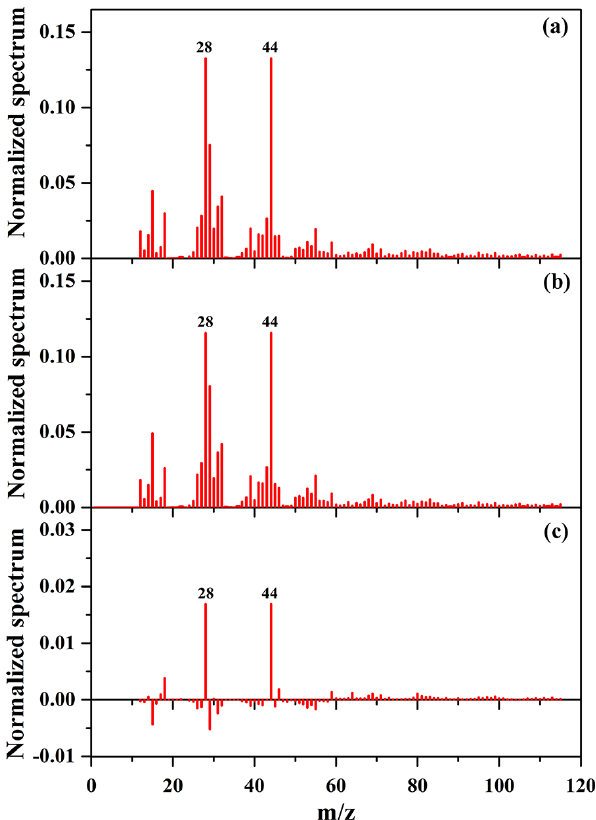
Figure 7. Mass spectra of SOA with NaCl (a) and ( NH 4 ) 2 SO 4 (b) as seed particles obtained by the HR-ToF-AMS, as well as their difference mass spectrum (c = a − b